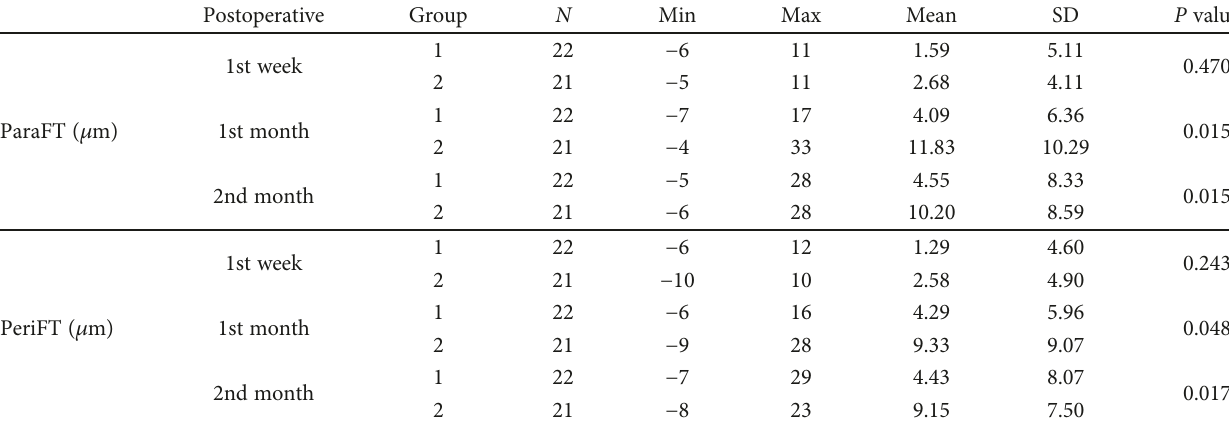
Table 4: Postoperative changes in parafoveal thickness and perifoveal thickness.